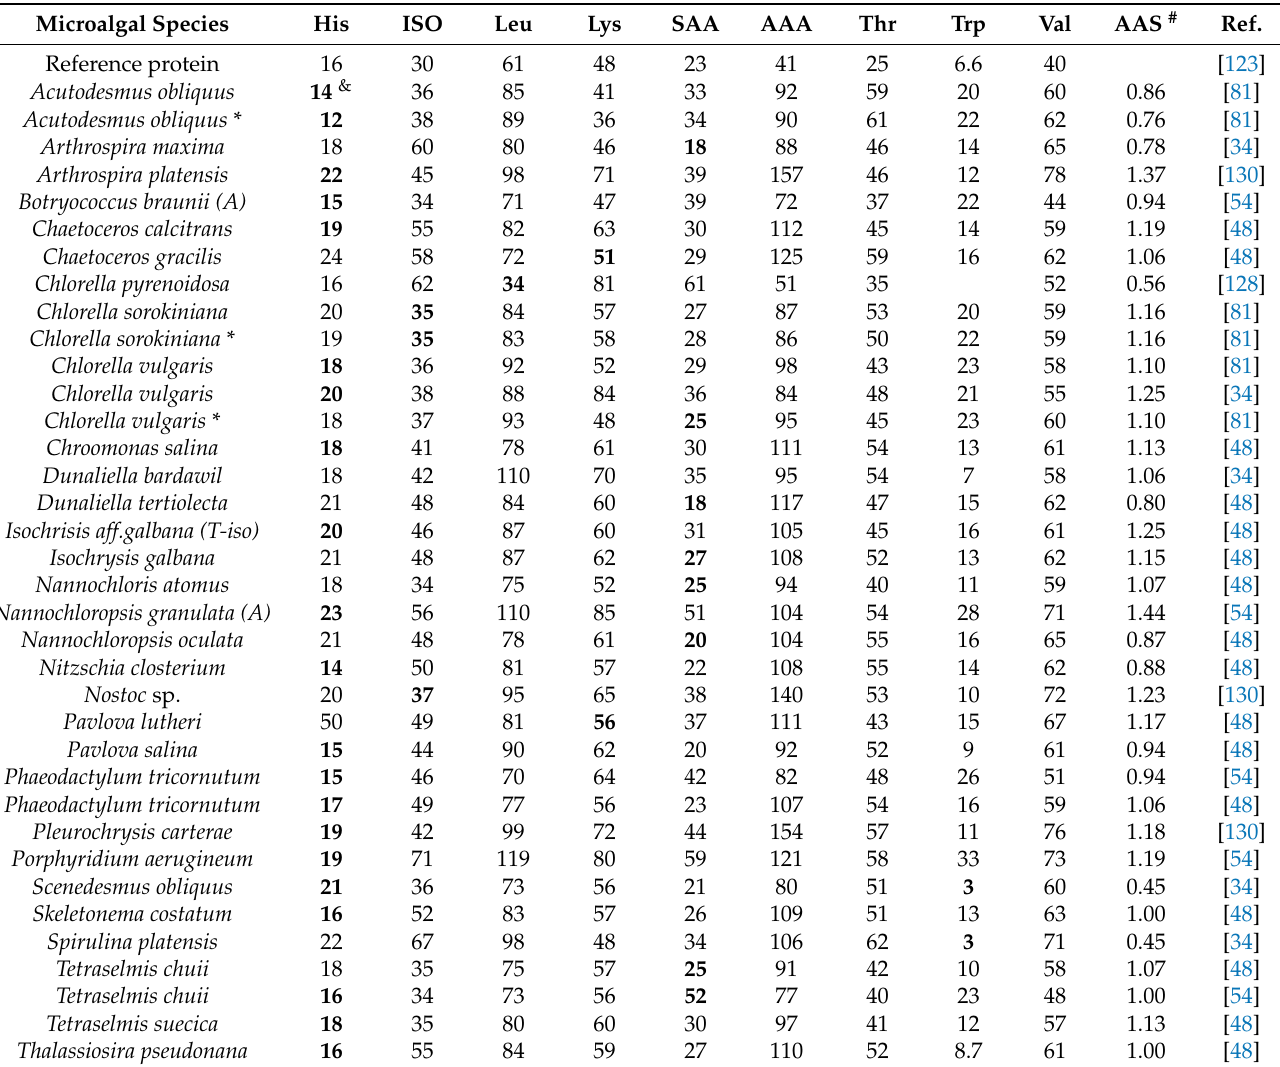
Table 2. Amino acid profile and score of different microalgal